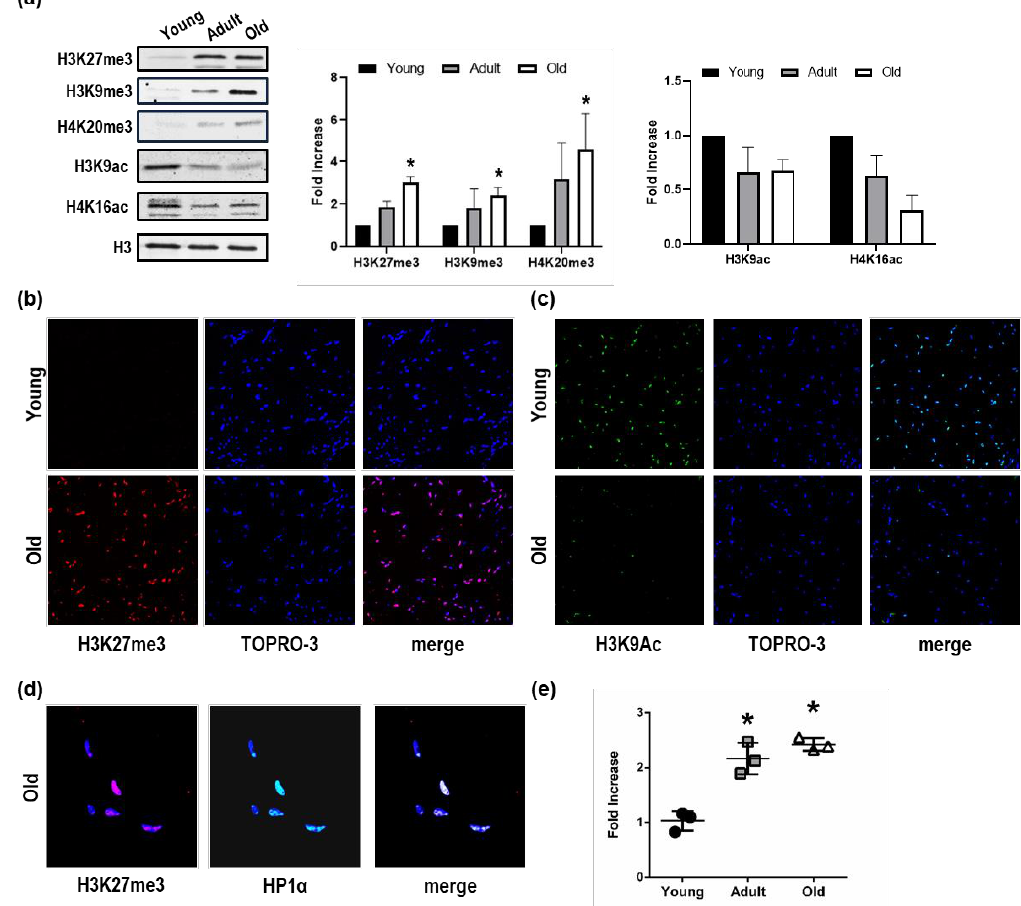
Figure 1. Repressive histone mark accumulation and activating histone mark decrease in Nfu skeletal muscle tissue with age. ( a ) Left panel: Representative Western blot analysis of H3K27me3, H3K9me3, H4K20me3, H3K9ac, and H4K16ac expression in young, adult, and old Nfu muscle tissue. Total histone 3 (H3) was used as loading control. Right panel: Related densitometry analysis of H3K27me3, H3K9me3, H4K20me3, H3K9ac, and H4K16ac expression in muscle tissue ( n = 4). * p < 0.05 vs young. ( b ) Representative confocal microscopy images of H3K27me3 (red) in young (upper panel) and old (lower panel) Nfu skeletal muscle tissue. Nuclei were counterstained with TOPRO-3 (blue). Magnification 40× ( n = 5). ( c ) Representative confocal microscopy images of H3K9Ac (green) in young (upper panel) and old (lower panel) Nfu skeletal muscle tissue; nuclei were counterstained with TOPRO-3 (blue). Magnification 40× ( n = 5). ( d ) Representative confocal microscopy images of H3K27me3 (red, left panel) and heterochromatin protein 1α (HP1α, green, middle panel) in old Nfu skeletal muscle tissue. Merged fluorescence images are shown in the right panel (merge). Nuclei were counterstained with TOPRO-3 (blue). Magnification 40× ( n = 5). ( e ) Whole skeletal muscle global DNA quantification of 5-methylcitosine (5 mC) in young (black circles), adult (gray squares), and old (white triangles) Nfu skeletal muscle tissue expressed as fold-change versus young ( n = 3). * p < 0.05 vs young.